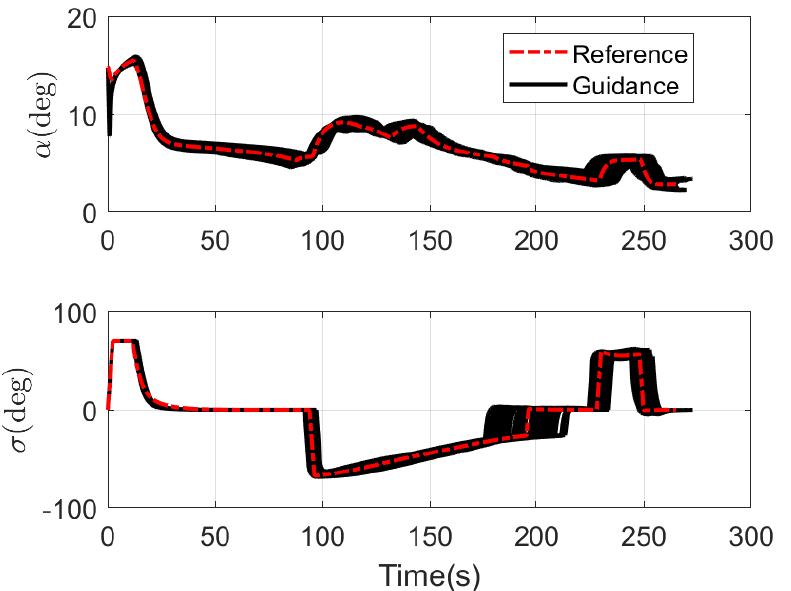
Figure 6. Angle of attack and bank angle profiles with respect to time in Monte Carlo